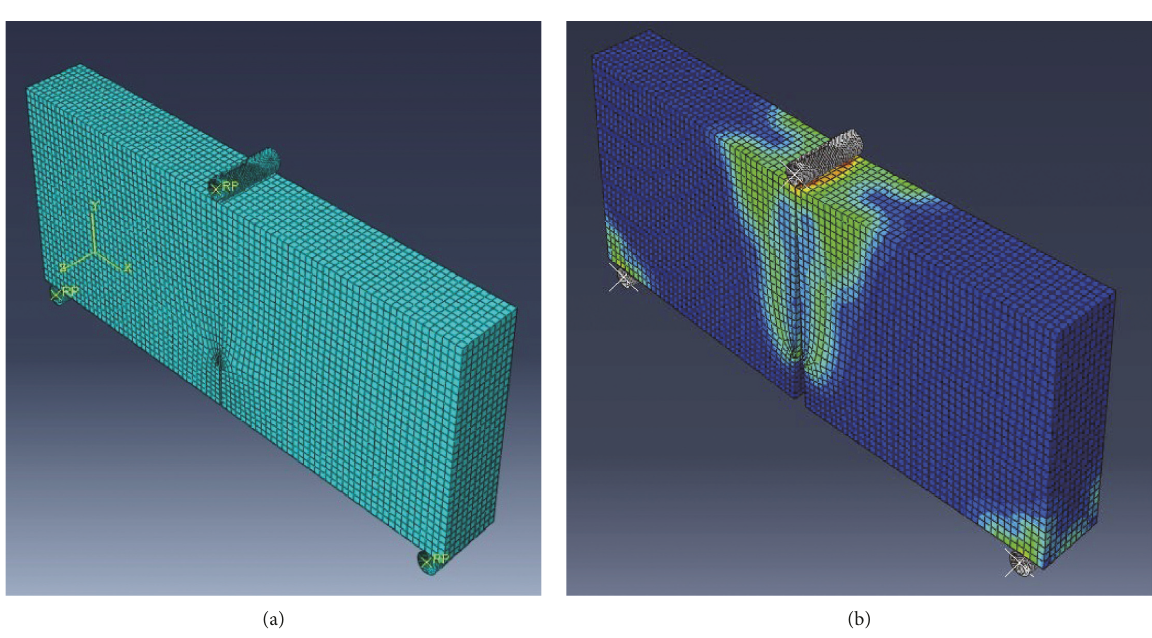
Figure 8: Numerical analysis of mesh division and stress map. (a) Mesh division. (b) Stress